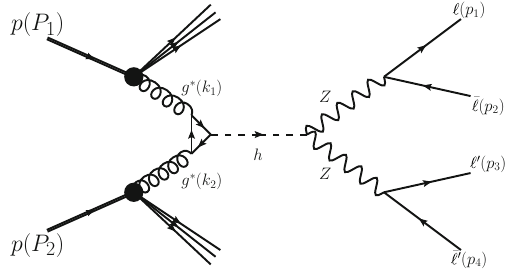
Fig. 1 Momentum assignment for the process g ∗ g ∗ → h → Z Z ∗ → 4